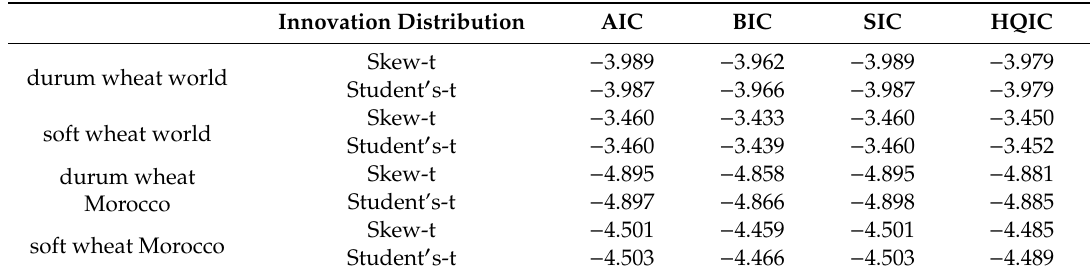
Table 3. ARMA GARCH model comparison.